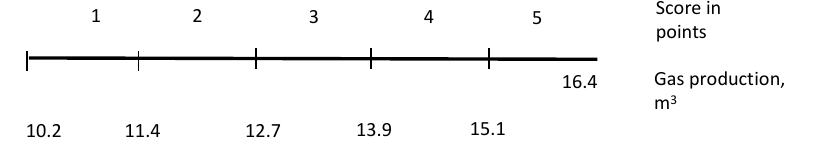
Figure 2. Base scales for score in points (source: designed by authors).